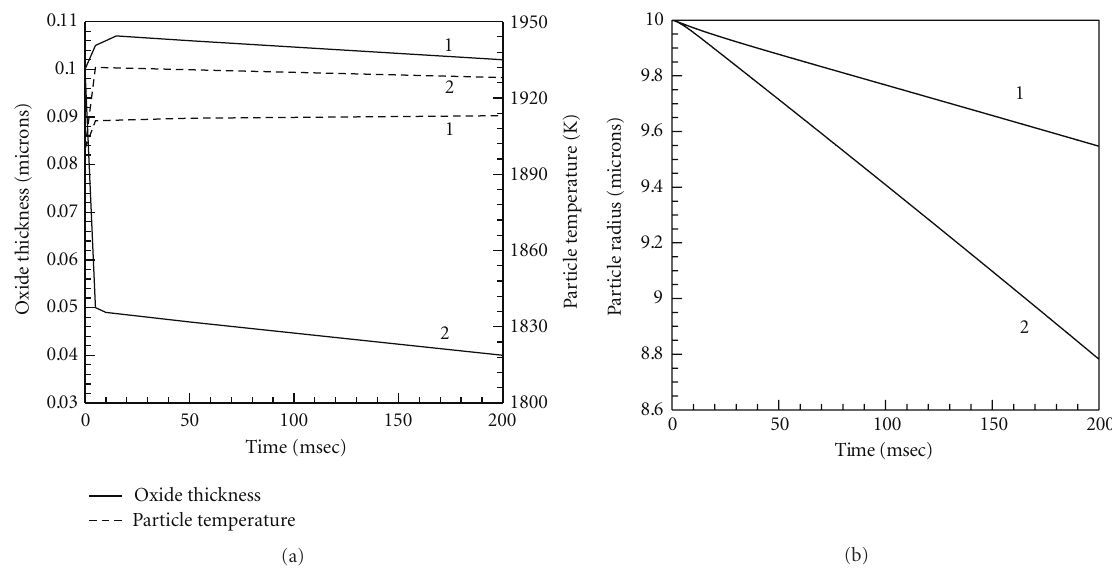
Figure 4: Predicted time dependence of important variables for particle which ignites at ambient temperature of 1900 K (a) King’s Model (b) our model with film moving).